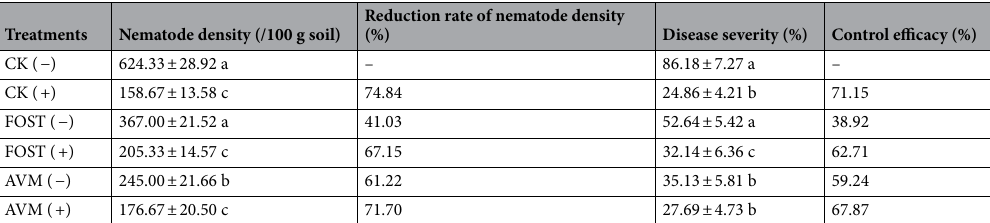
Table 1. Effects of different treatments on the density of root knot nematode juveniles in rhizpsphere soils of greenhouse-grown watermelon. Data in the table are mean of 3 replicates. Means followed by different letters within a column are significantly different ( P < 0.05, Duncan’s test). CK: control; FOST: fosthiazate; AVM: avermectin. (+ /-) stands for with and without B418 inoculation.